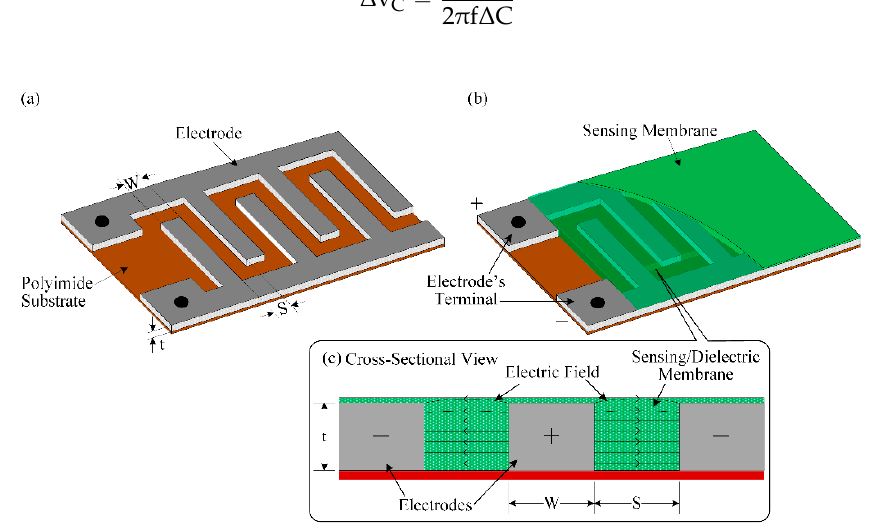
Figure 3. Schematic diagram of the interdigitated electrode: ( a ) without the dielectric/sensing membrane; ( b ) dielectric/sensing membrane in the IDE; and ( c ) cross-sectional view of the IDC.